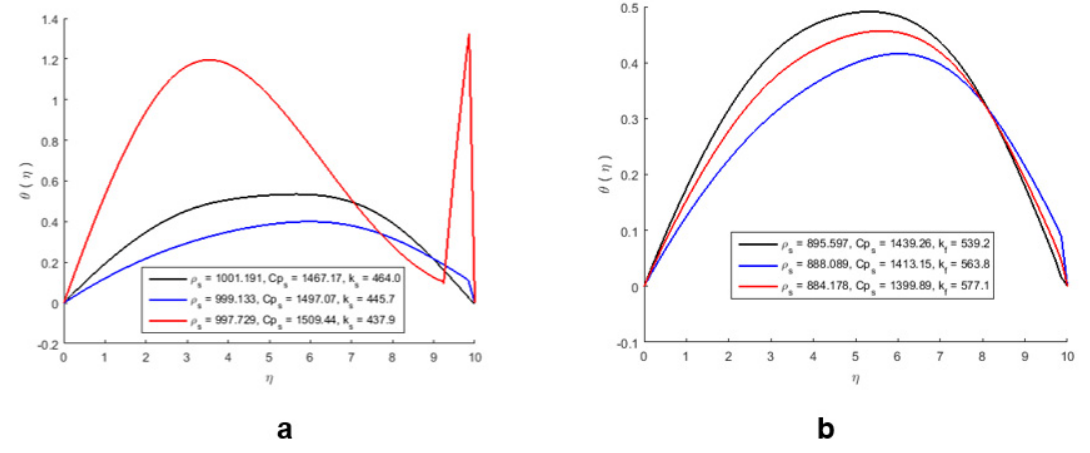
Figure 8. The effect of nanoparticles on the temperature profile of pure nanoparticles ( a ) and mixed nanoparticles ( b ).